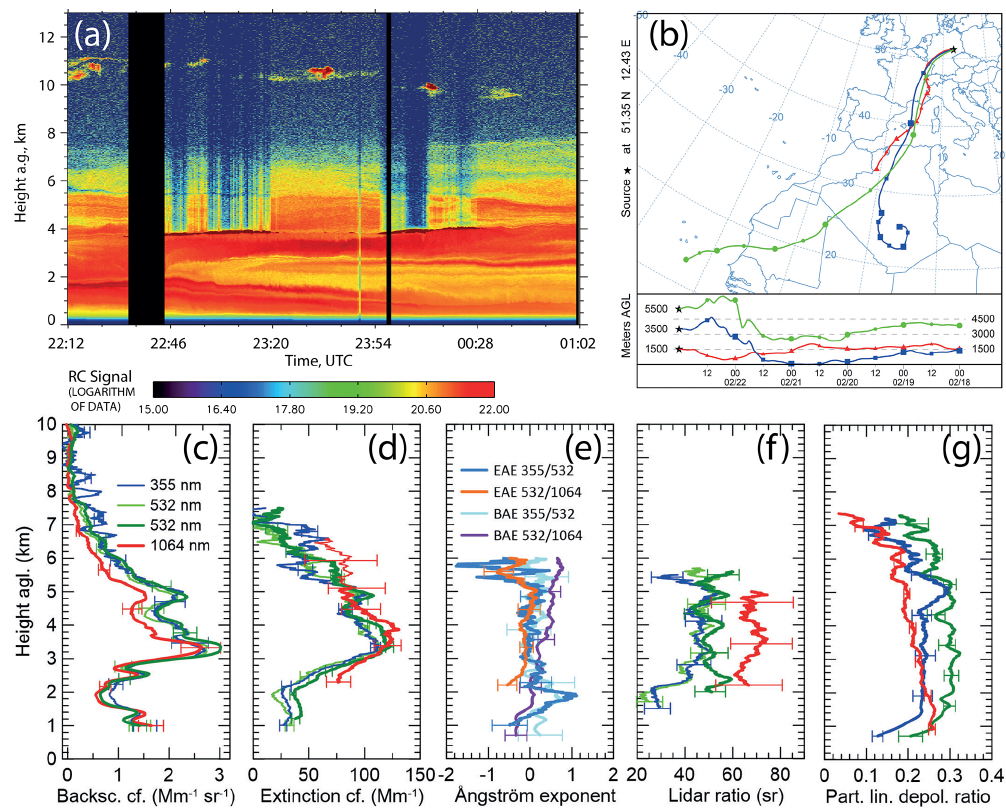
Figure 1. Saharan dust observations at Leipzig on 22–23 February 2021 at 22:12–01:02UTC. (a) Time–height display of the 532nm cross- polarized, range-corrected (RC) signal. (b) HYSPLIT back trajectory for 23 February 2021 at 00:00UTC ( < 2d from the Sahara to Leipzig; please note that the date format in this panel is month/day). (c) Particle backscatter coefficient (200m vertical smoothing). (d) Particle extinction coefficient (950m vertical smoothing, 2000m (3290m) at 1064nm below (above) 5km). (e) Extinction Ångström exponent (EAE) and backscatter Ångström exponent (BAE) for the given wavelengths pairs: 355/532 from Polly XT and 532/1064 from BERTHA. (f) Lidar ratio (950m vertical smoothing, 2000m at 1064nm). (g) Particle linear depolarization ratio (200m vertical smoothing, 750m at 355nm). BERTHA provided measurements at 532nm (dark green) and 1064nm (red), and Polly XT provided measurements at 355nm (blue) and 532nm (light green). All optical properties are shown for the period 22:45–01:02UTC, except for the depolarization ratios shown at 22:12–22:32UTC to be at the same time as the 1064nm depolarization ratio measurement.